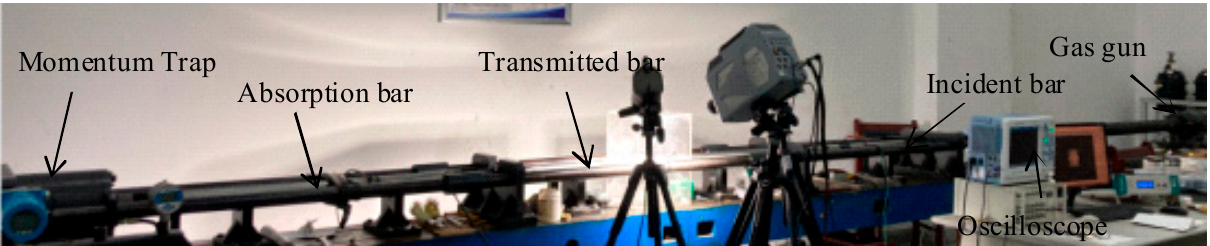
alloy with diameter of 5 cm, density of 7.82 g/cm 3 and elastic modulus of 210 GPa. The incident bar impact specimen produced waveform dispersion, and a 0.1 cm rubber pad was added to the end of the incident bar as a waveform shaper. Specimens were sandwiched between the incident bar and the transmitted bar. In order to reduce the friction between the incident bar and the end face of the rock specimen, lubricant was applied to both ends of the specimen, so that energy consumption was negligible from the friction between incident bar and specimens.